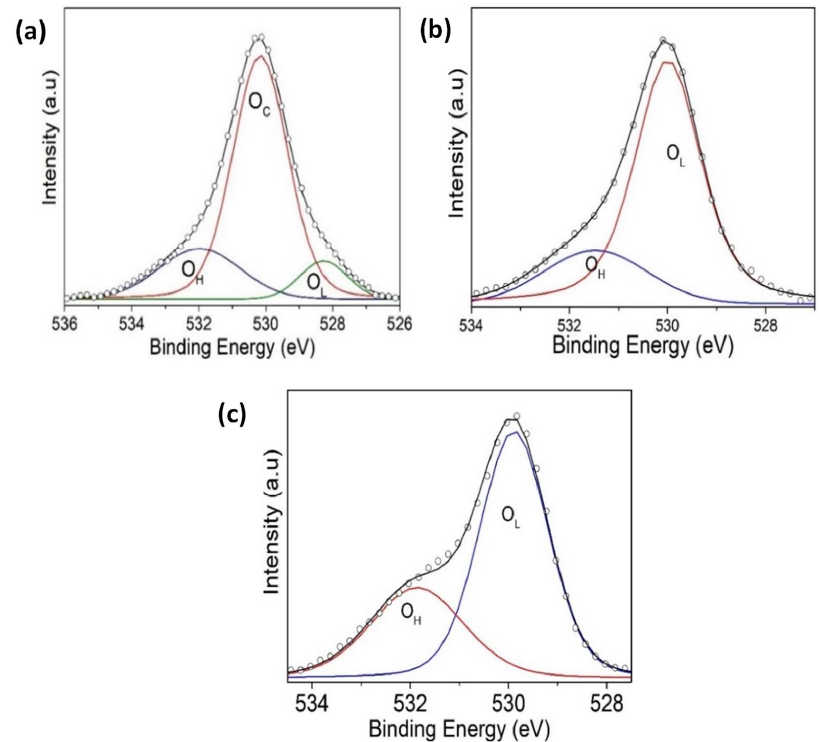
Figure 12. An XPS narrow scan of O 1s signals for ( a ) BFO/SrTiO 3 , ( b ) BFO/VO 2 /Al 2 O 3 with a BFO of 30 nm, and ( c ) BFO/VO 2 /Al 2 O 3 with a BFO of 60 nm. For the bilayer thin films, see Figure 9a in the red and black colors; a BFO of 30 nm can be seen in Figures 10–12b, and a BFO of 60 nm can be seen in Figures 10–12c. We can observe that the Fe(2 p ) doublet and Bi(4 f ) doublet’s binding energies difference of 13.6 eV and 5.31 eV are maintained. Therefore, the BFO thin films with a layer of 30 nm exhibit more oxidation states, as well as a shift towards higher binding energies. However, an ion bombardment revealed that the amount of Fe 3+ increases in the BFO thin films, unlike the surface where there was a higher presence of the Fe 2+ oxidation state. In the bilayers, there was a small displacement of the maximums towards higher values of binding energy; however, this did not increase the number of oxidation states, and it can be noted that at lesser layers, Fe 3+ increases in proportion. On the other hand, it is evident that Bi 3+ is very predominant in both the monolayers and bilayers. Instead, there is an increase in the con- tribution of the oxides of the lattice (metallic oxides, O L ) for the bilayers, which is a good indication that the surface area is more homogeneous and that there is less contamination. In addition, hydroxyl oxygen (O H ) increases in the thin films with a lower growth power and in the eroded sample, which may suggest that these thin films could be more photo- catalytic. Figure 13 and Table 1 show a summary of the atomic percentages of the thin films analyzed in this work. It is observed that the VO 2 films most indicated to be coupled with the BFO films are those with 60 min of growth since they have a higher percentage of vanadium on the surface and present a higher proportion of V 4+ . On the other hand, the most suitable BFO films to couple in the bilayer with VO 2 are those with a BFO layer of 30 nm because they show iron with a higher atomic percentage in the surface area and a higher Fe 3+ ratio.